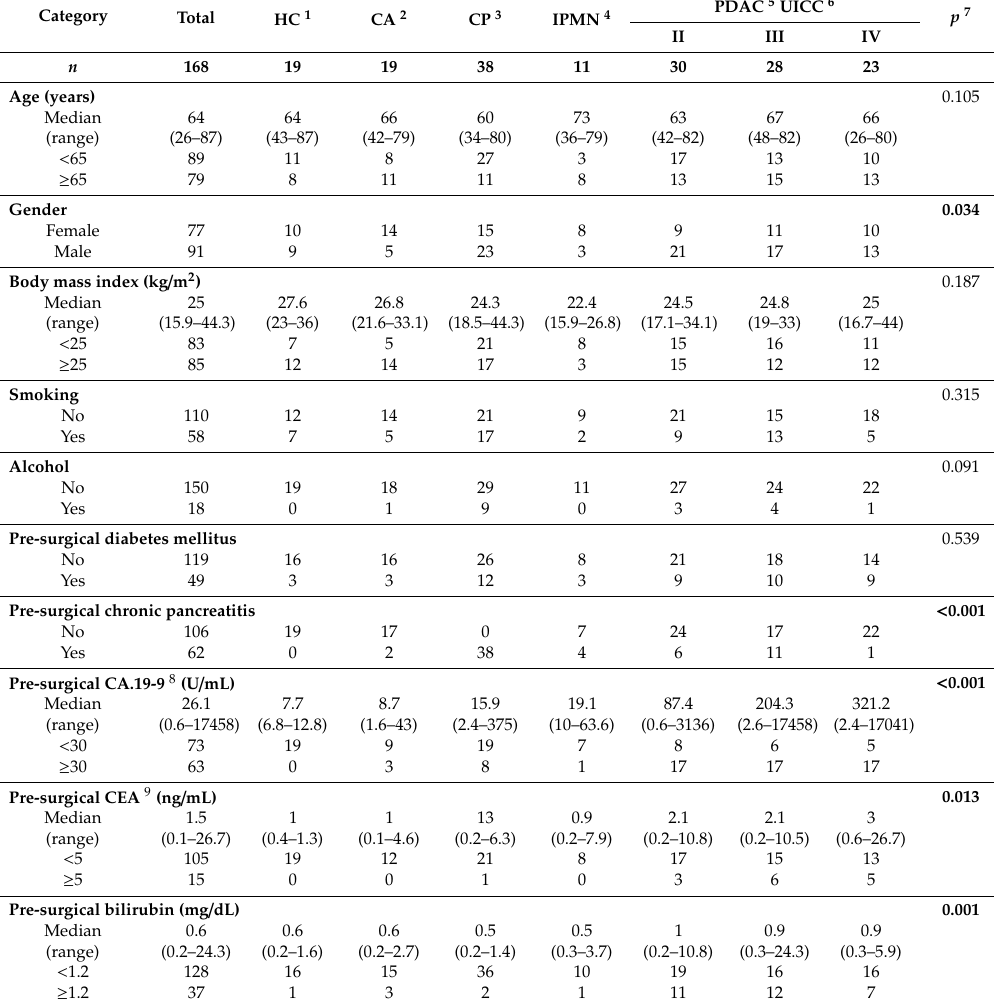
Table 1. Summary of clinicopathologic data of all patients enrolled in this